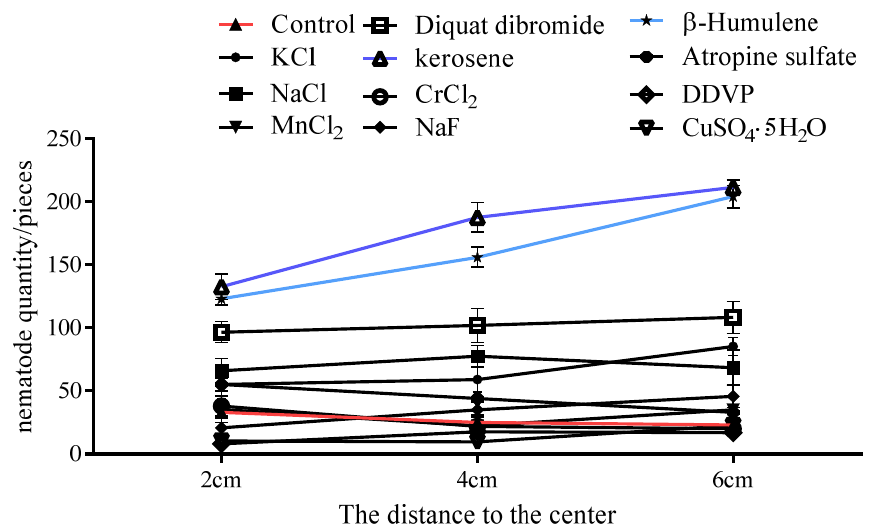
Figure 4. Movement of PWN in agar blocks after treatment with different chemicals.